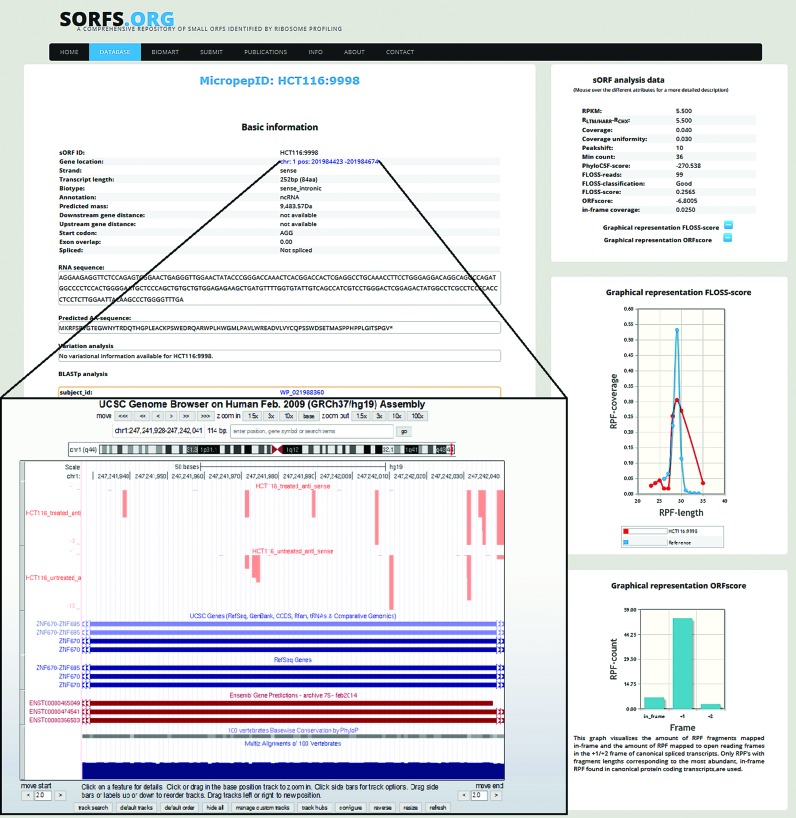
sORF detail page.